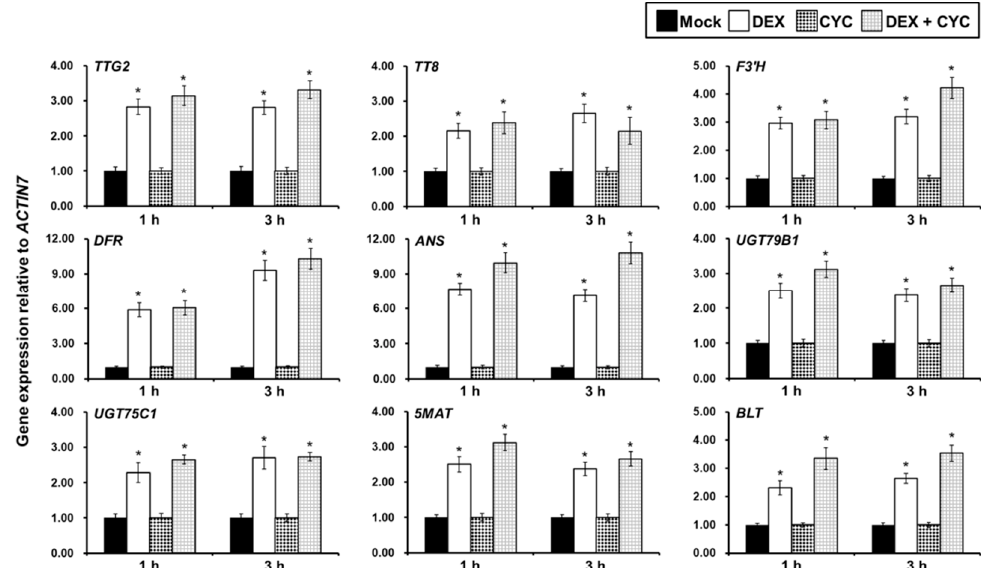
Figure 3. Induced TRANSPARENT TESTA GLABRA1 (TTG1) activity transcriptionally promotes the expression of several genes involved in flavonoid biosynthesis, including TTG2 , TT8 , F3’H , DFR , ANS , UGT79B1 , UGT75C1 , and 5MAT , and the gene related to trichome formation BLT in the young shoots and expanding true leaves. The ttg1-13 35S:TTG1-GR young shoots and expanding true leaves at 20 days after germination were mock-treated (Mock) or treated with 10 µ M dexamethasone (DEX), 5 µ M cycloheximide (CYC), or 10 µ M DEX plus 5 µ M CYC (DEX + CYC). The expression of these genes was determined after 1 or 3 h of treatment using qRT-PCR analyses. The house-keeping gene ACTIN7 was used as the internal control. The expression level of each gene was first calculated relative to ACTIN7 , and its expression levels in both Mock and CYC treatments were set to 1. Asterisks indicate significant differences in gene expression in DEX-treated samples compared with their respective controls (two-tailed paired Student’s t test, p ≤ 0.05). Values are means ± SD ( n = 3). Error bars denote SD.